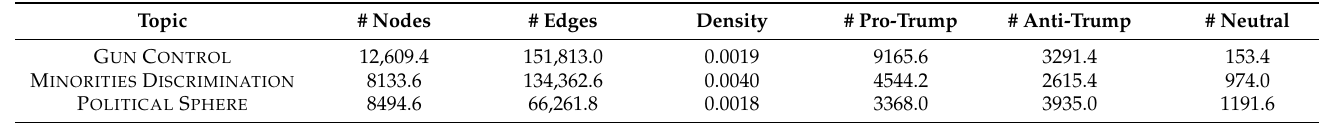
Table 4. For each topic, network statistics averaged across semesters: size of the network in terms of nodes and edges, network density, number of users with a Pro-Trump, Anti-Trump, or Neutral leaning score. Topic # Nodes # Edges #